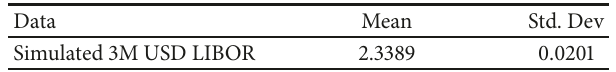
Table 2: MCCLMM Parameter Estimates.